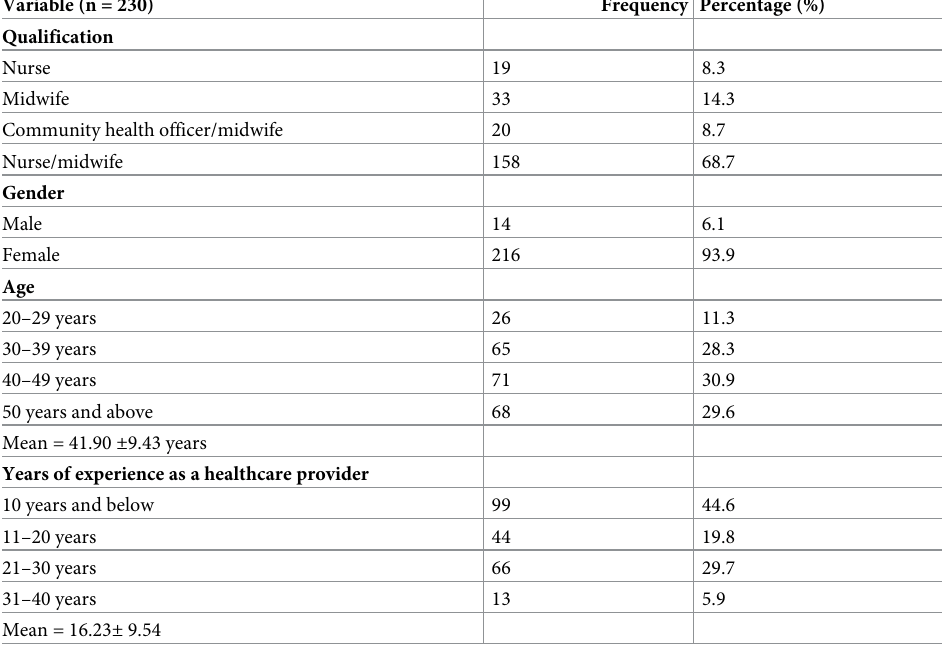
Table 1. Sociodemographic characteristics of